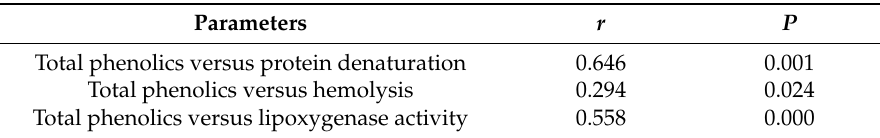
Table 1. Pearson correlations between major bioactives (total phenolics, total flavonoids, total carotenoids) and % inhibition of protein denaturation, hemolysis denaturation, lipoxygenase activity, and proteinase activity of cooked leafy